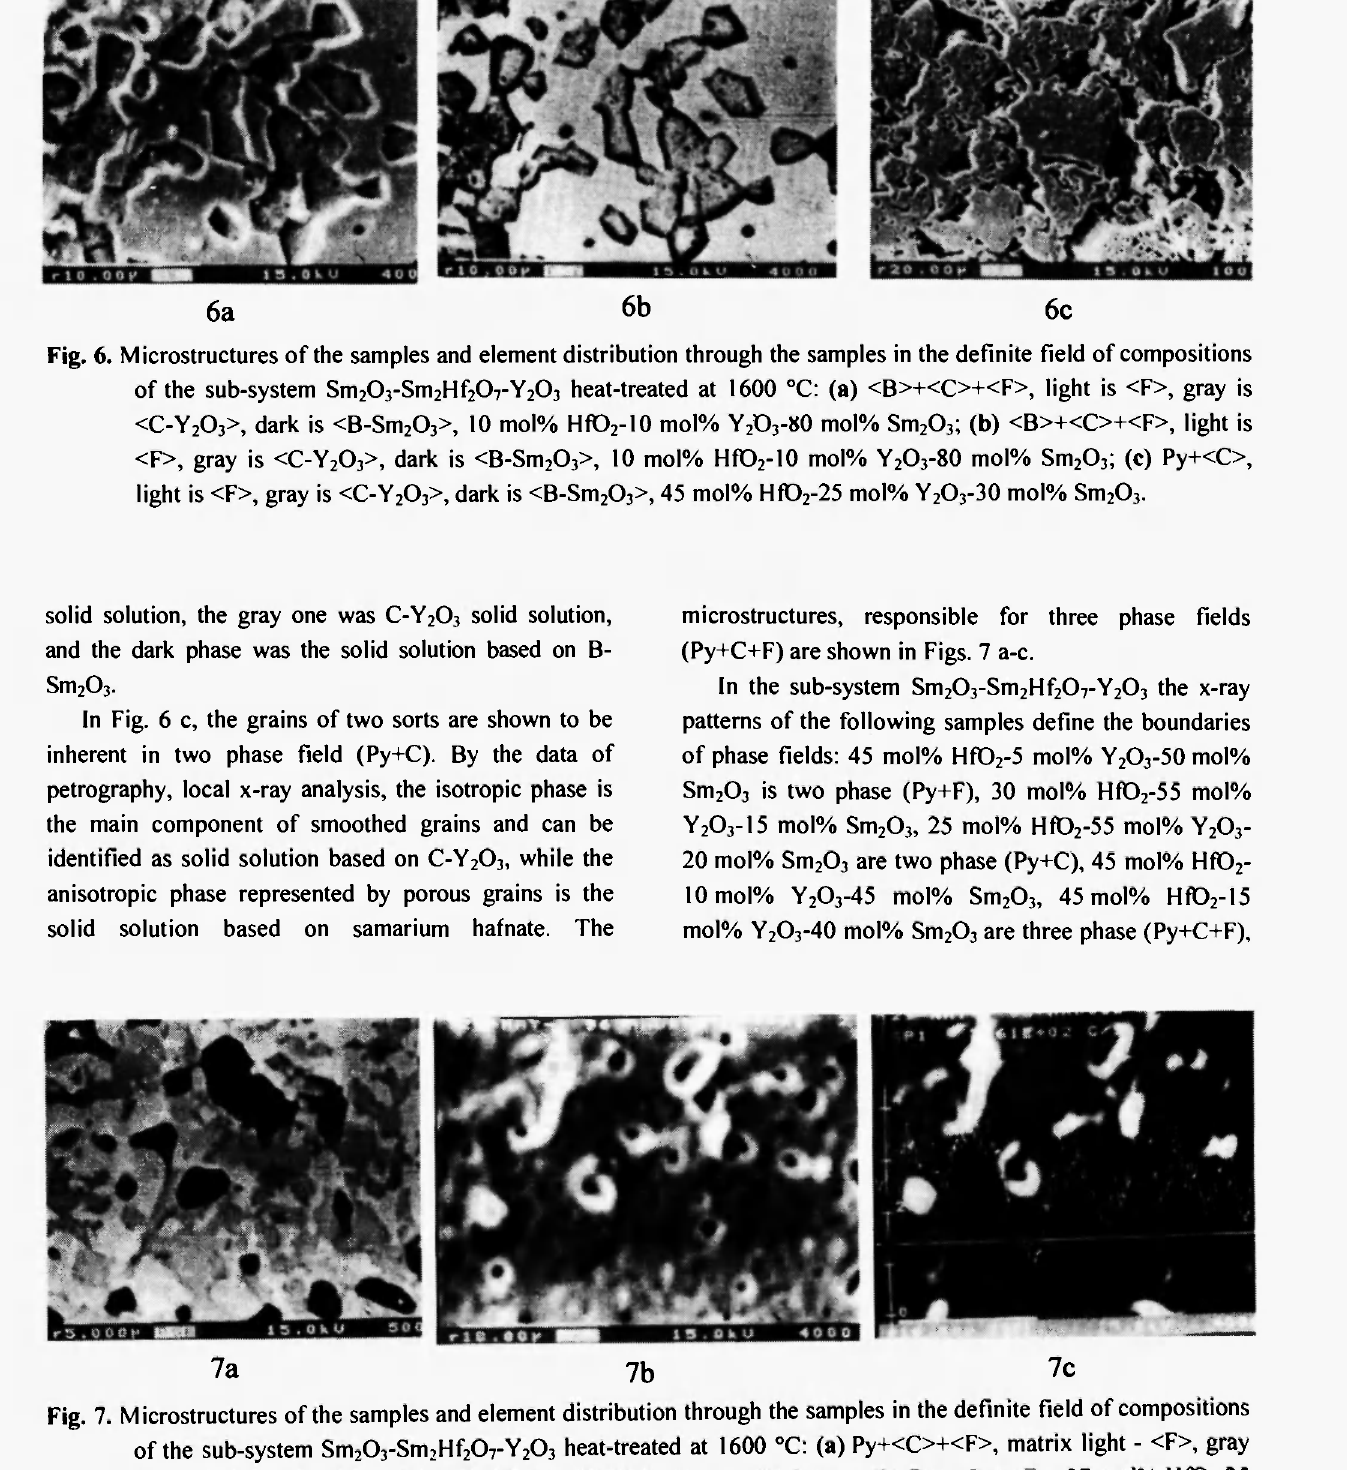
Fig. 7. Microstructures of the samples and element distribution through the samples in the definite field of compositions of the sub-system Sm 2 0 3 -Sm 2 Hf 2 0 7 -Y 2 0 3 heat-treated at 1600 °C: (a) Py+<C>+<F>, matrix light - <F>, gray is Py, dark is <C>, 35 mol% HfO r 32.5 mol% Y 2 O r 32.5 mol% Sm 2 0 3 ; (b) Py+<C>+<F>, 37 mol% Hfö 2